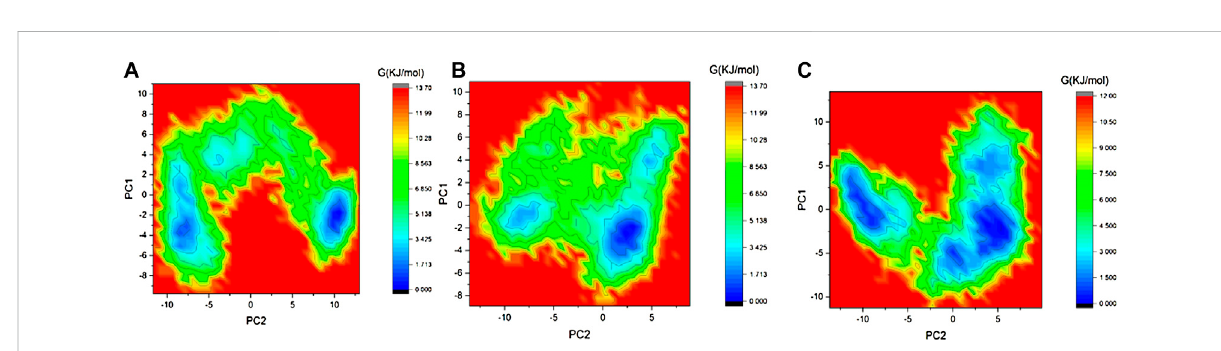
FIGURE 8 GFE landscape of 3CLP-control (A) , 3CLP-Sorafenib (B) , and 3CLP-YM201636 (C)